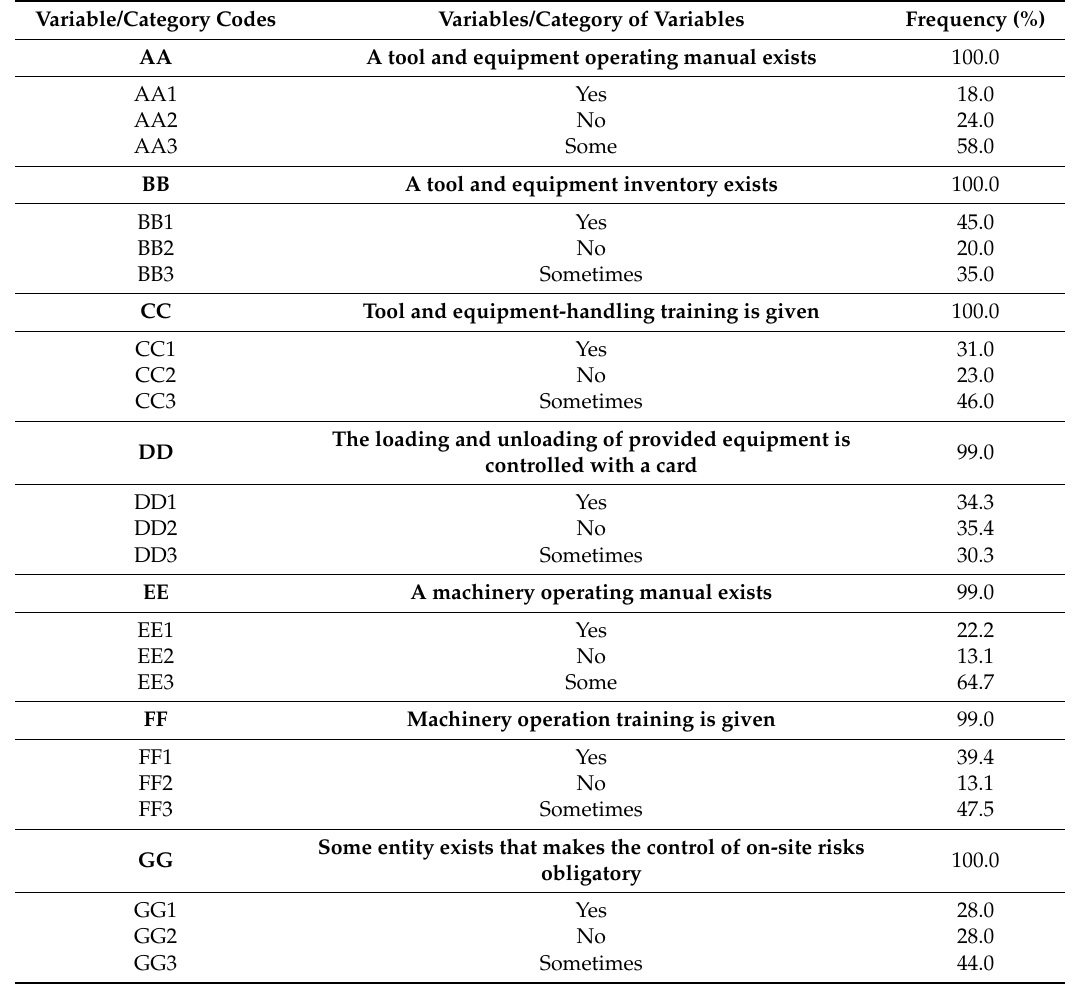
Table A4. Nomenclature and frequency of the categories of variables for Prevention Activities and Health and Safety Management in the company and on site (3rd